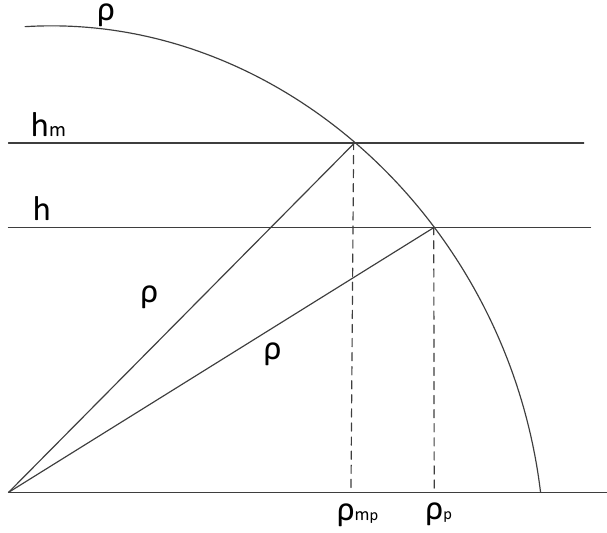
Figure 10. Difference between the projection in the slant range for the same range measure and different altitude.